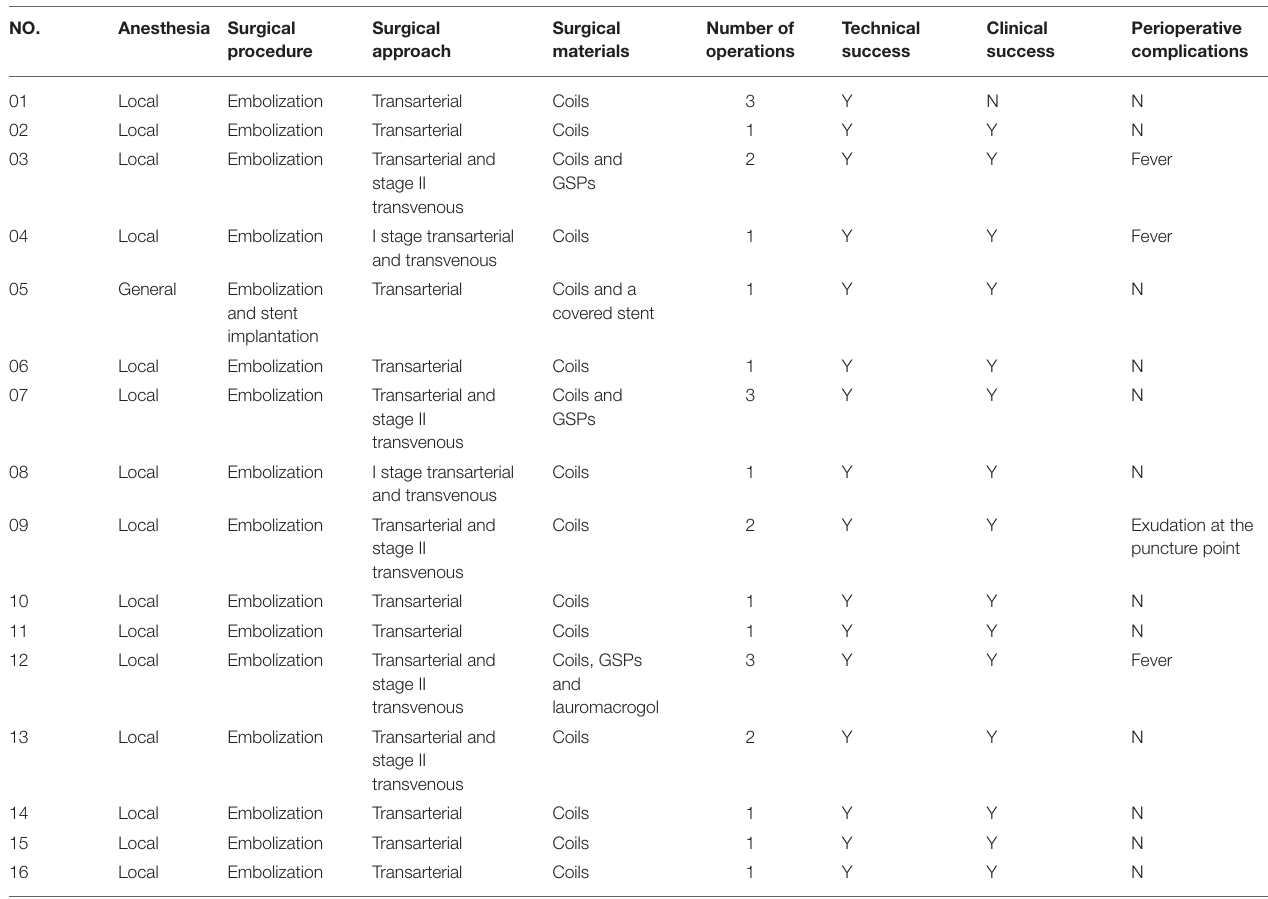
TABLE 3 | Surgical characteristics of patients with iliac arteriovenous fistulas (IAVFs). NO. Anesthesia Surgical Surgical procedure